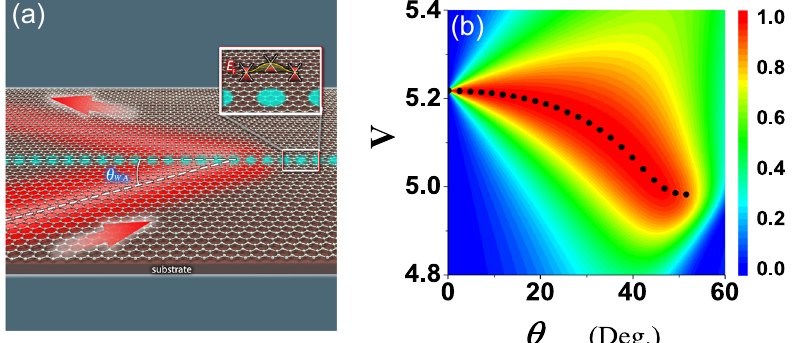
Fig. 1 The -1st-order transmittance. a Schematic view of the abrupt change in the propagation direction of the electron beam by a metagrating realized by a one-dimensional array of quantum dots on graphene. b Phase diagram of the -1st-order transmittance as a function of the bias applied on the QDs and angle θ WA between the incident wave and the array. The calculation assumes QDs with radius R s = 1 and incident energy E = 0.8, in reduced units. The bias V is controllable in practical applications. The black dotted line indicates unity ef fi